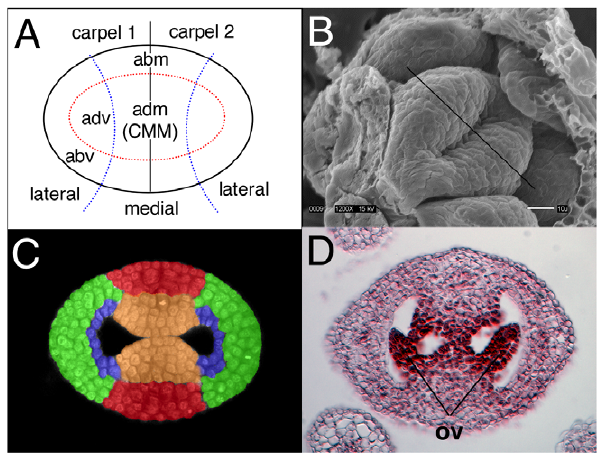
Figure 1. Spatial domains of the developing Arabidopsis gynoecium. A) Diagrammatic representation of the Arabidopsis gynoecial primordia at stage 6. Blue dotted arcs separate the lateral domains from the medial domain. The medial domain represents the fused margins of the two component carpels. The red dotted oval separates abaxial (outer) positions from adaxial (inner) positions. adm - adaxial margin; abm - abaxial margin; adv - adaxial valve; abv - abaxial valve, CMM - carpel margin meristem. B) Scanning electron micrograph of stage 6 gynoecial primordium. Medial plane is marked with a black line. C) False colored confocal cross section of a stage 8 gynoecium. Gynoecial domains have been colored with approximation. orange - carpel margin meristem/medial ridge; red - abaxial margin/replum; blue - adaxial valve; green - abaxial valve. D) Histological cross section of a stage 11 Arabidopsis gynoecium. Ovules (ov) are